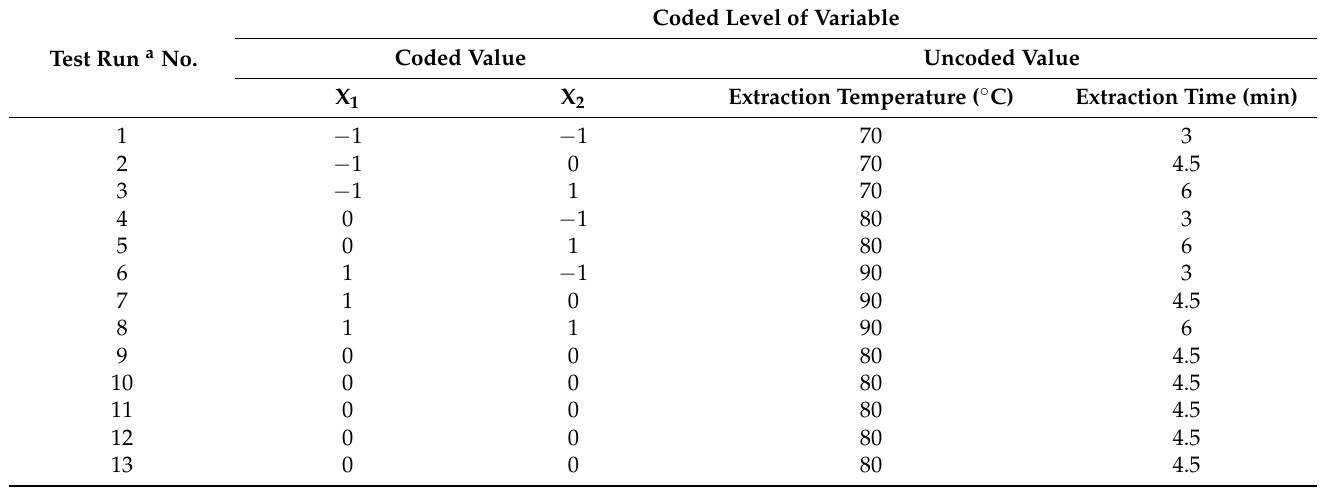
Table 1. Coded and uncoded level combinations of extraction temperature and time of roasted rice germ flavored herbal